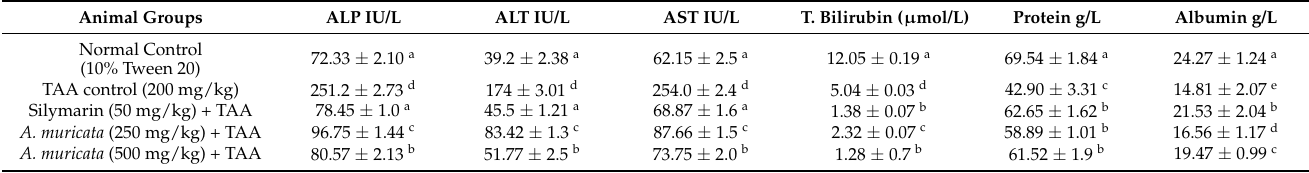
Table 4. Effects of A. muricata extracts on liver biochemical parameters in the serum of TAA-induced liver cirrhosis in